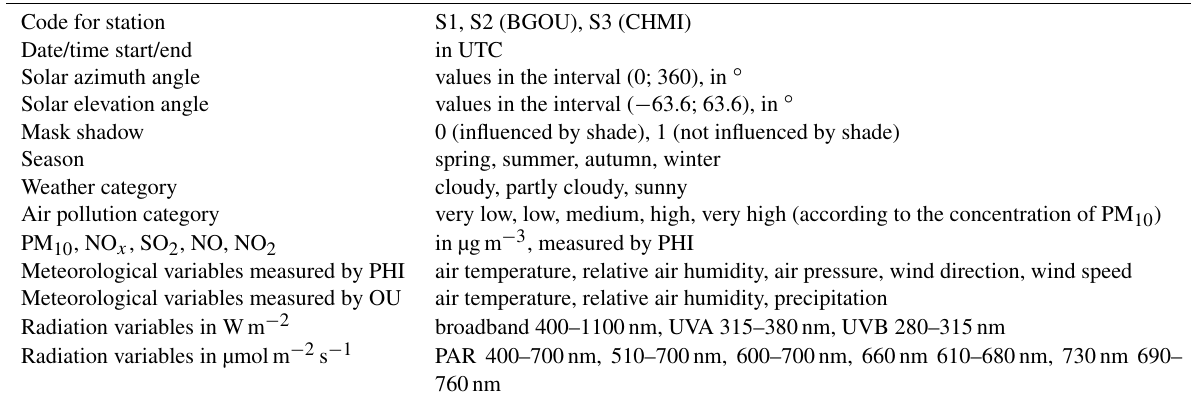
Table 6. A list of variables contained in the database. PHI means the Public Health Institute Ostrava. Code for station S1, S2 (BGOU), S3 (CHMI) Date/time start/end in UTC Solar azimuth angle values in the interval (0; 360), in ◦ values in the interval ( − 63.6; 63.6), in